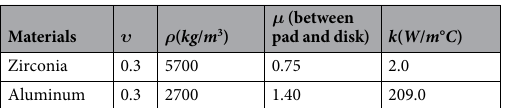
Table 1. Temperature-independent Material Properties 31 .